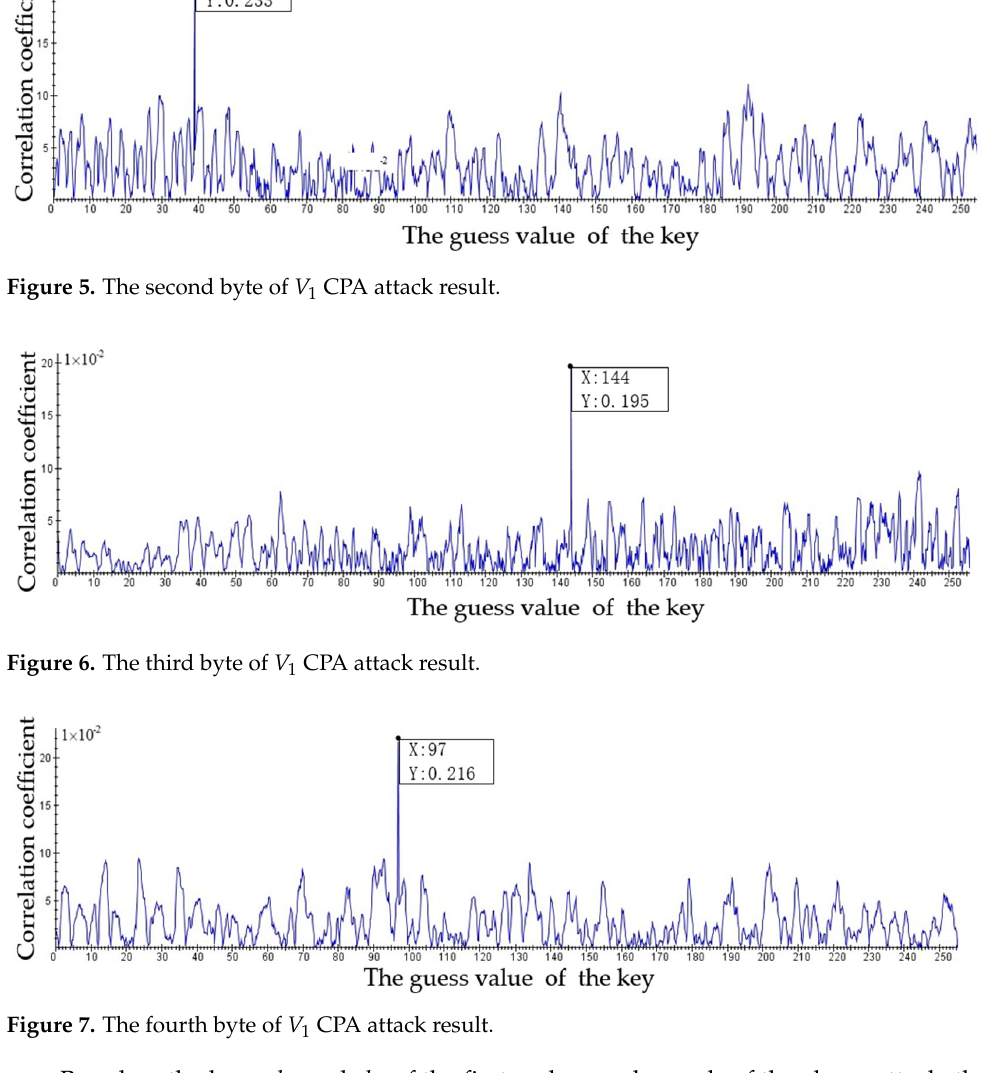
12 of 15 Figure 3. The power traces of SM4 encryption process.